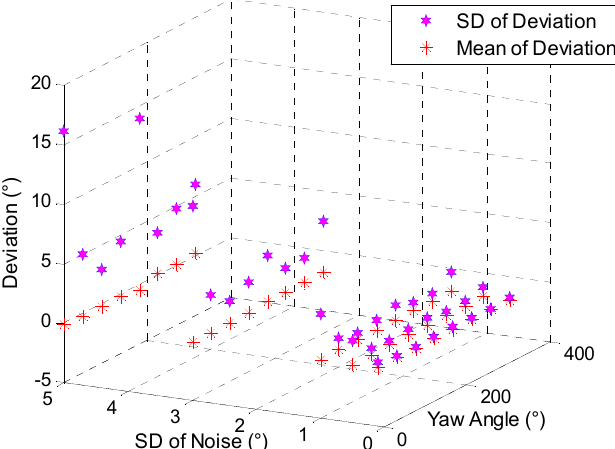
Figure 16. SD and mean of deviation of compensation angle caused by the noise.